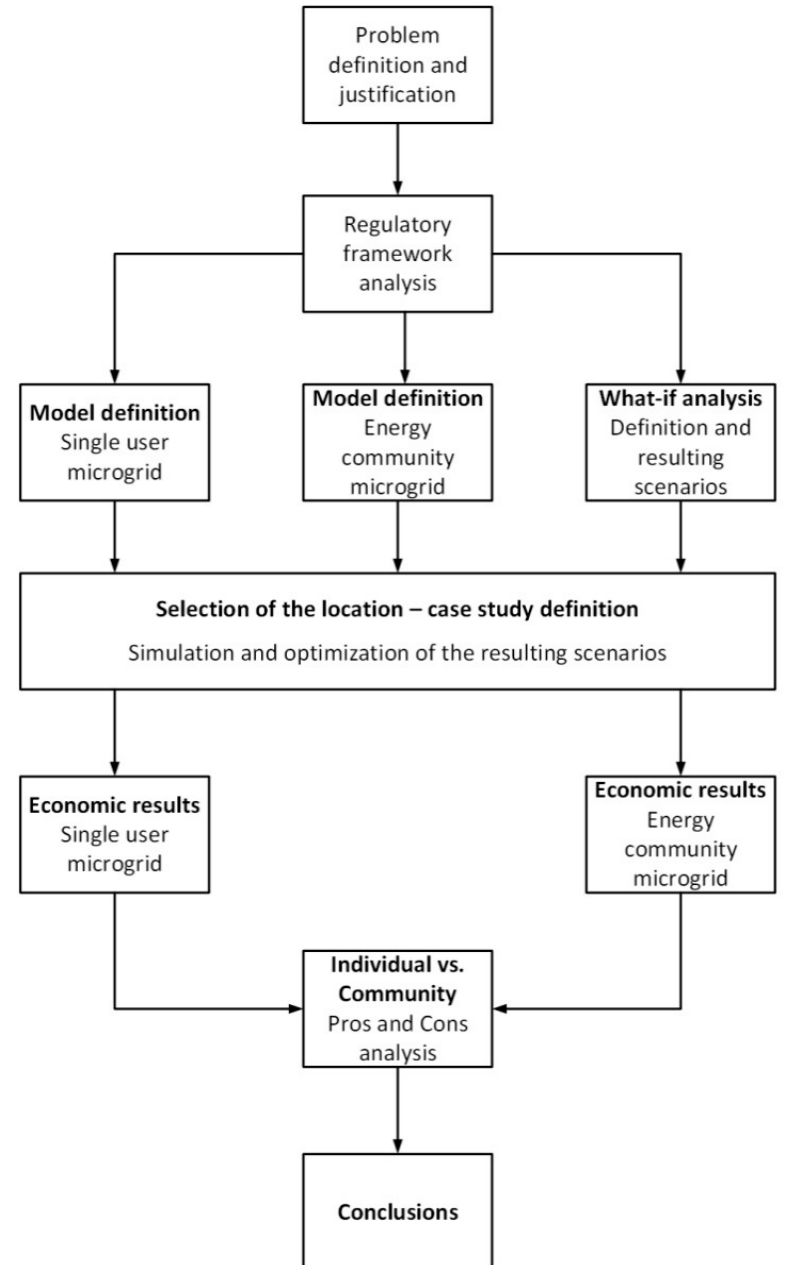
Figure 2. Methodology undertaken in this study. Source: self-elaboration.